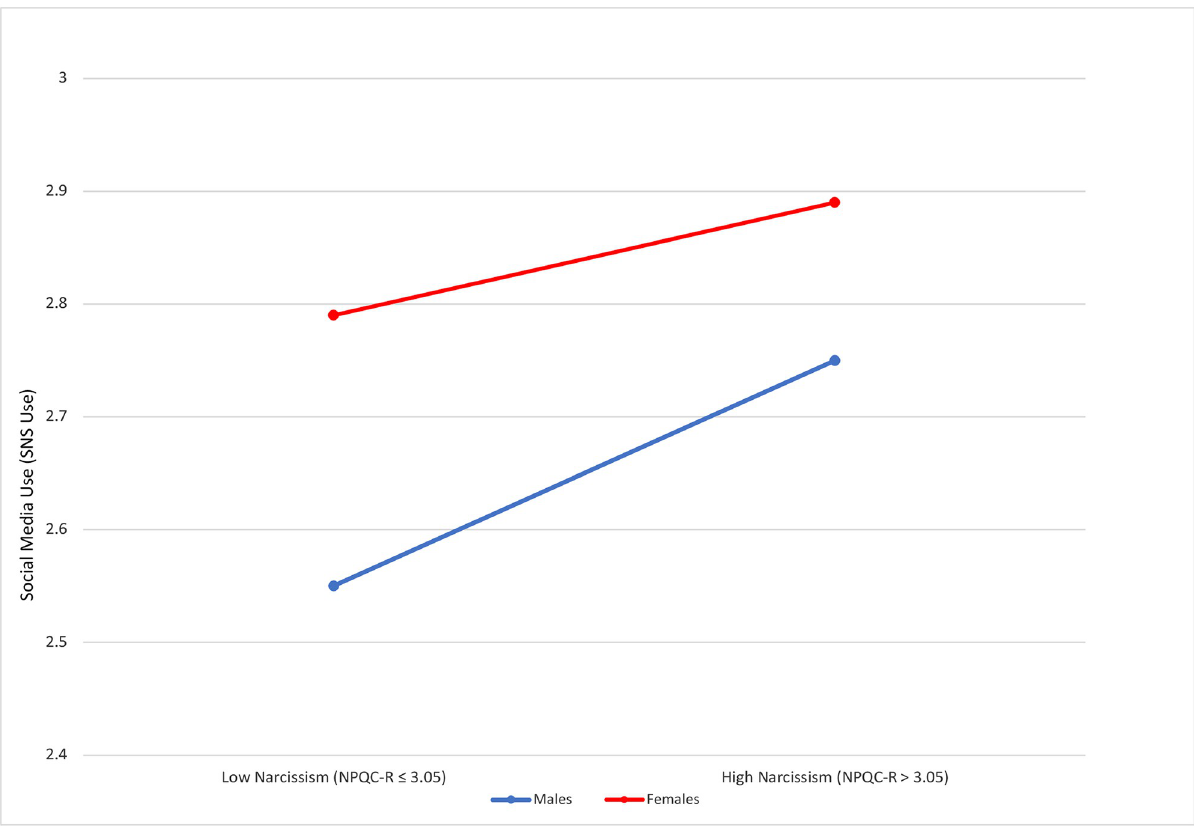
Fig 2. Social media use mean (SNS use) by gender and narcissism.